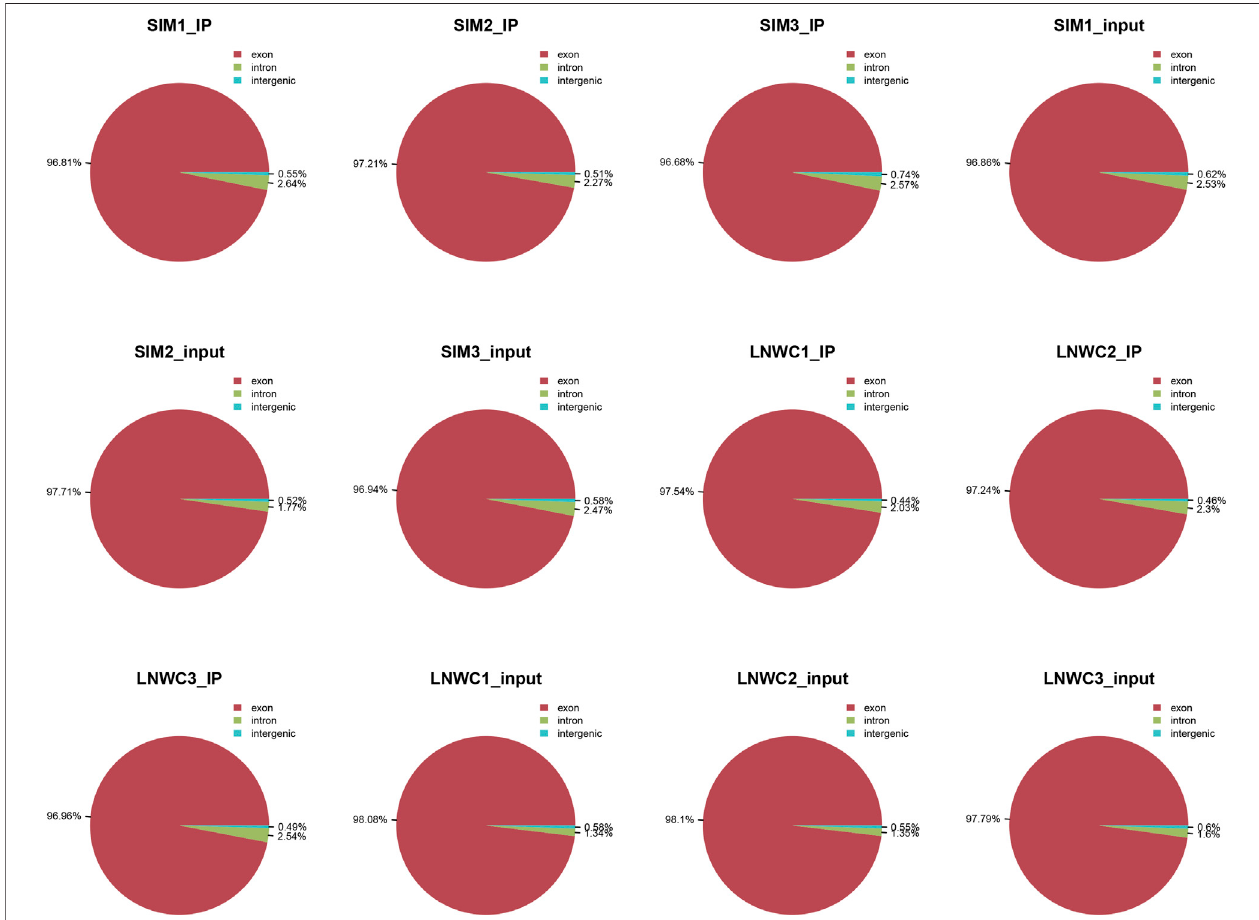
FIGURE 1 | Comparison of the regional distribution with reference to the genome.